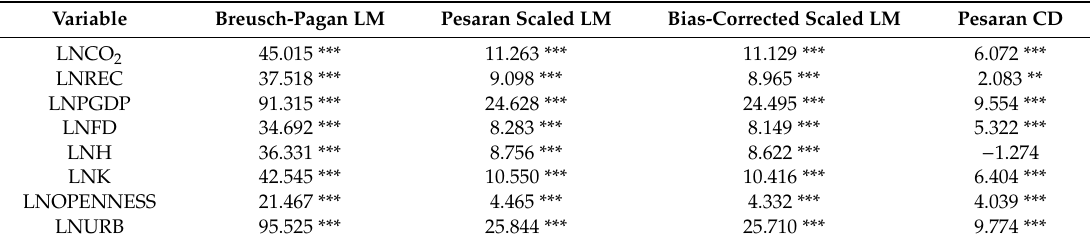
Table 5. Cross-section dependence